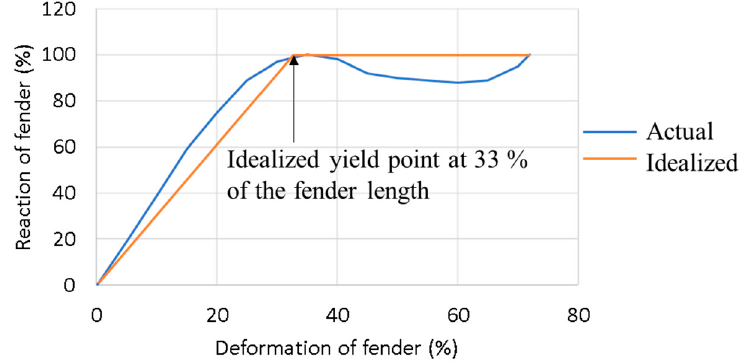
Figure 6. Detailed properties of steel structure ( a ) column and ( b ) beam.